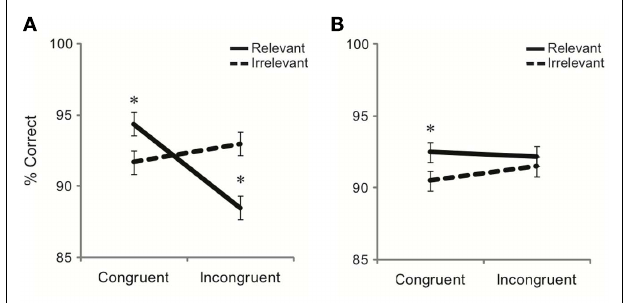
FIGURE 3 | Mean judgment accuracy by distracter relevance and congruence presented separately for (A) the emotion expression task and (B) the gender task. Error bars represent SE of the